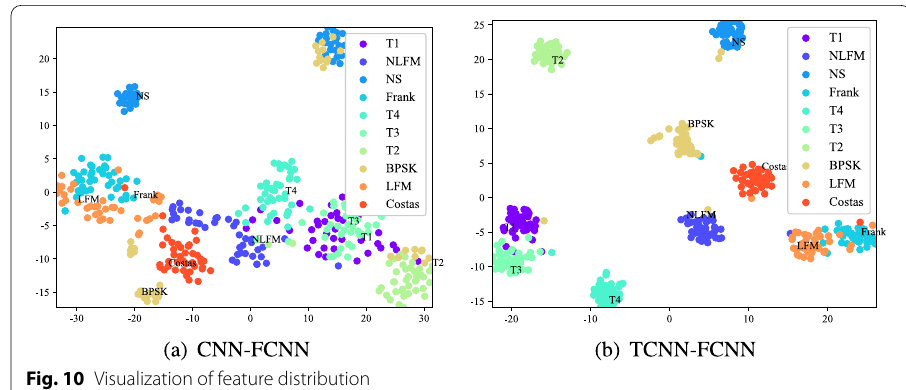
Fig. 10 Visualization of feature